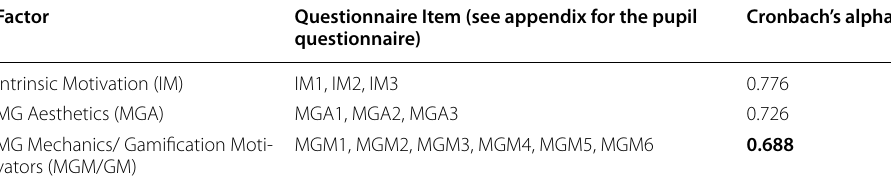
Bold is used to emphasize that factor MGM/GM has a cronbach value below the limit of 0.7